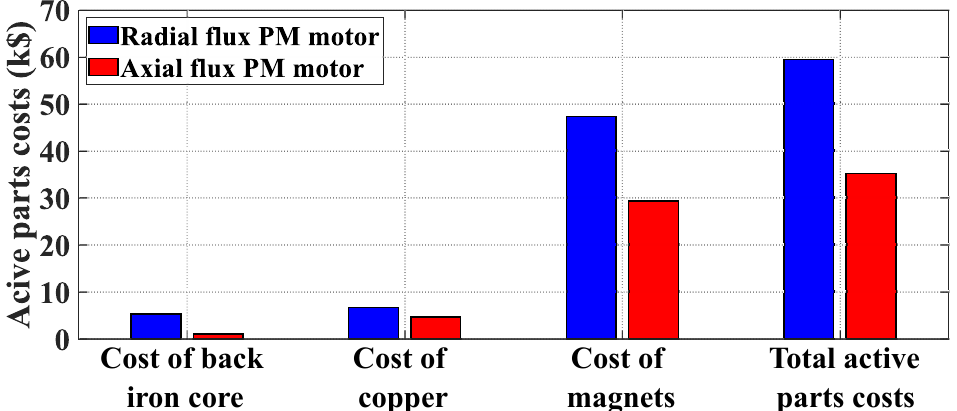
Figure 12. Comparison of the costs of double stator AFPM and RFPM motors’ active